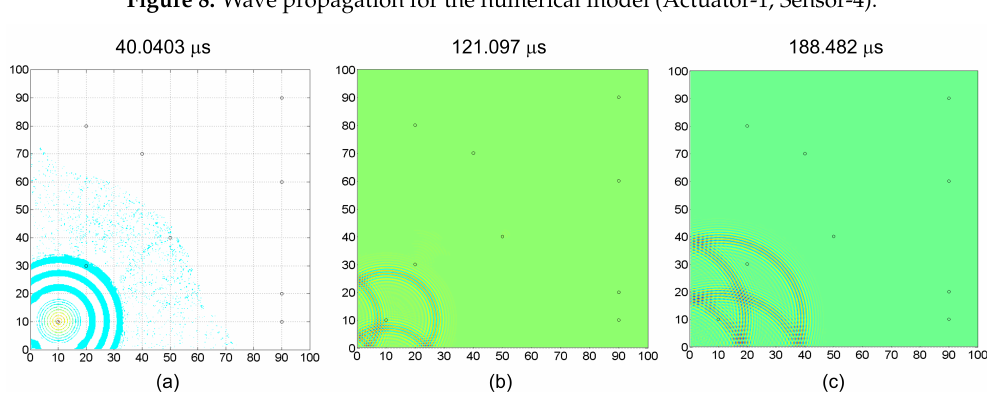
Figure 9. Wave propagation for the numerical model with actuation at 1 and sensing at 4. ( a ) Arrival of the S0 wave; ( b ) Arrival of the A0 wave; ( c ) Arrival of the reflected A0 wave